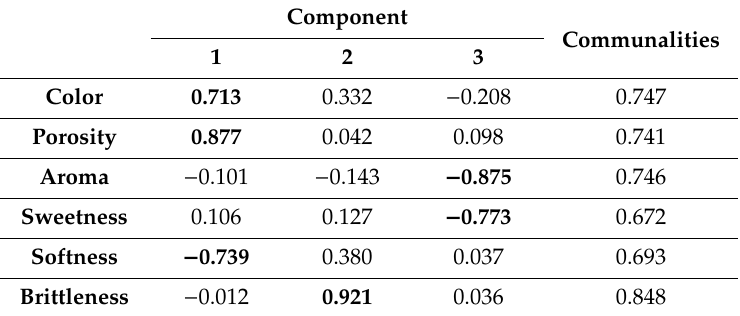
Figure 2. 3D Component plot in rotated space of correlation coefficients between sensory attributes (all the three components account for 74.1% of all the variation. Table 4. Pattern matrix table. Relationship between the correlation coefficients of sensory attributes with the three major components’ axes.